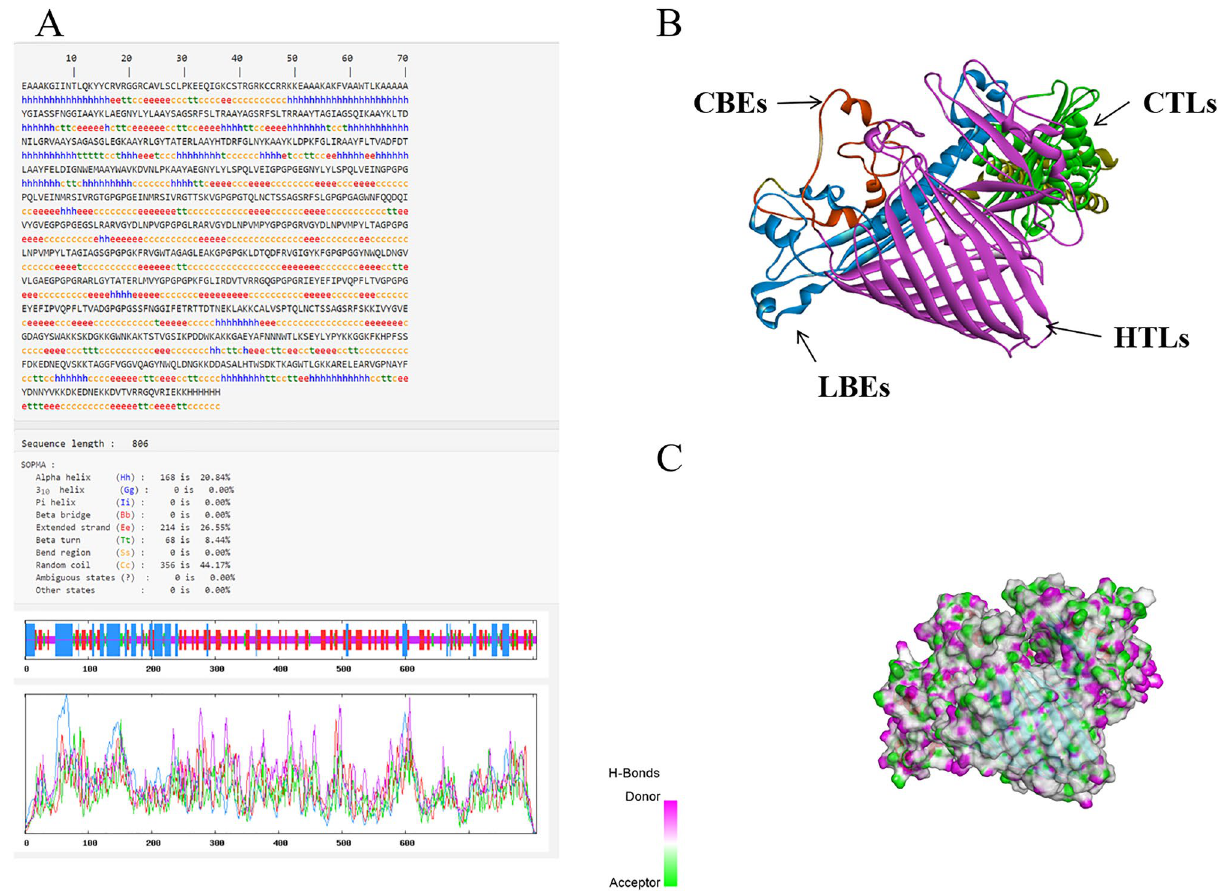
Figure 7. ( A ) The prediction of MEV secondary structure. ( B ) The prediction of MEV tertiary structure. ( C ) H-Bonds of MEV. As illustrated in the figure, the “pink area” stands for the donor, and the “green area” stands for the acceptor.